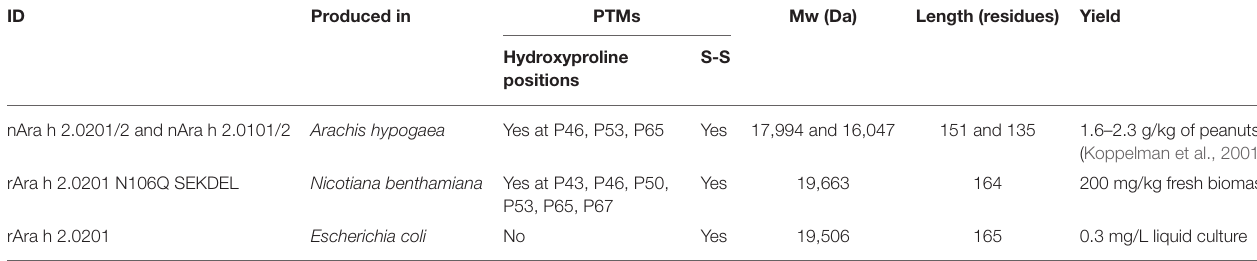
TABLE 1 | Protein characteristics of the Ara h 2 proteins used in this study.